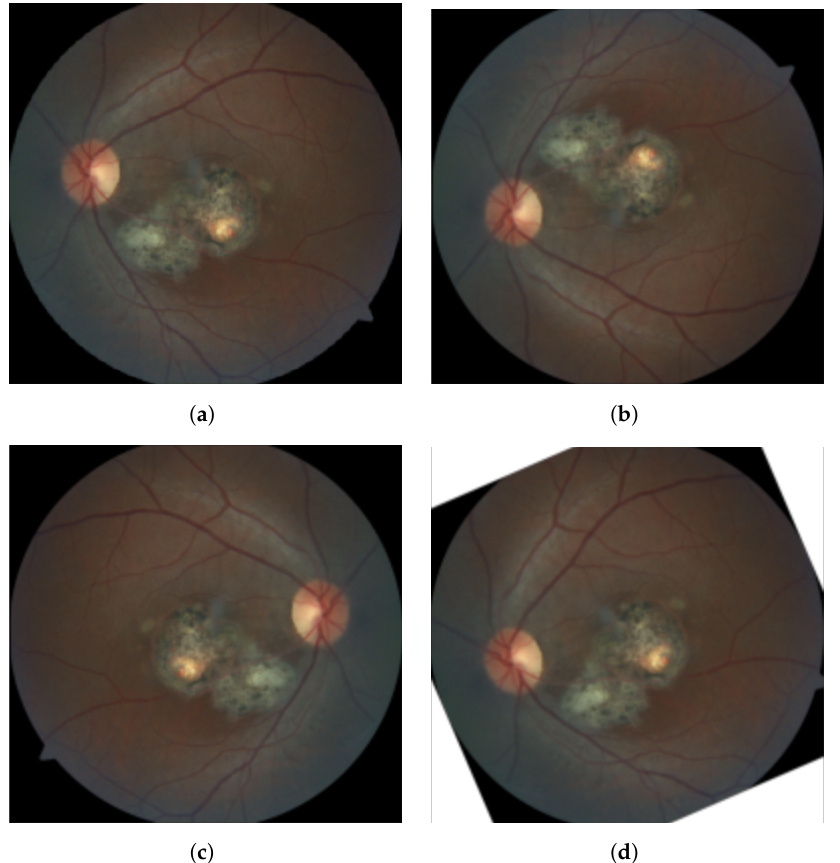
Figure 3. An original eye fundus training image ( a ) with some example transformations, such as vertical flip ( b ), horizontal flip ( c ) and rotation ( d ), which are computed for data